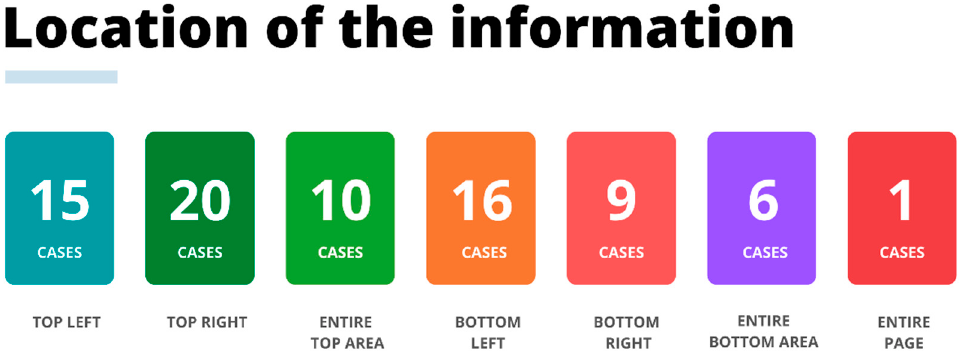
Figure 5. Location of the information about vaccines.